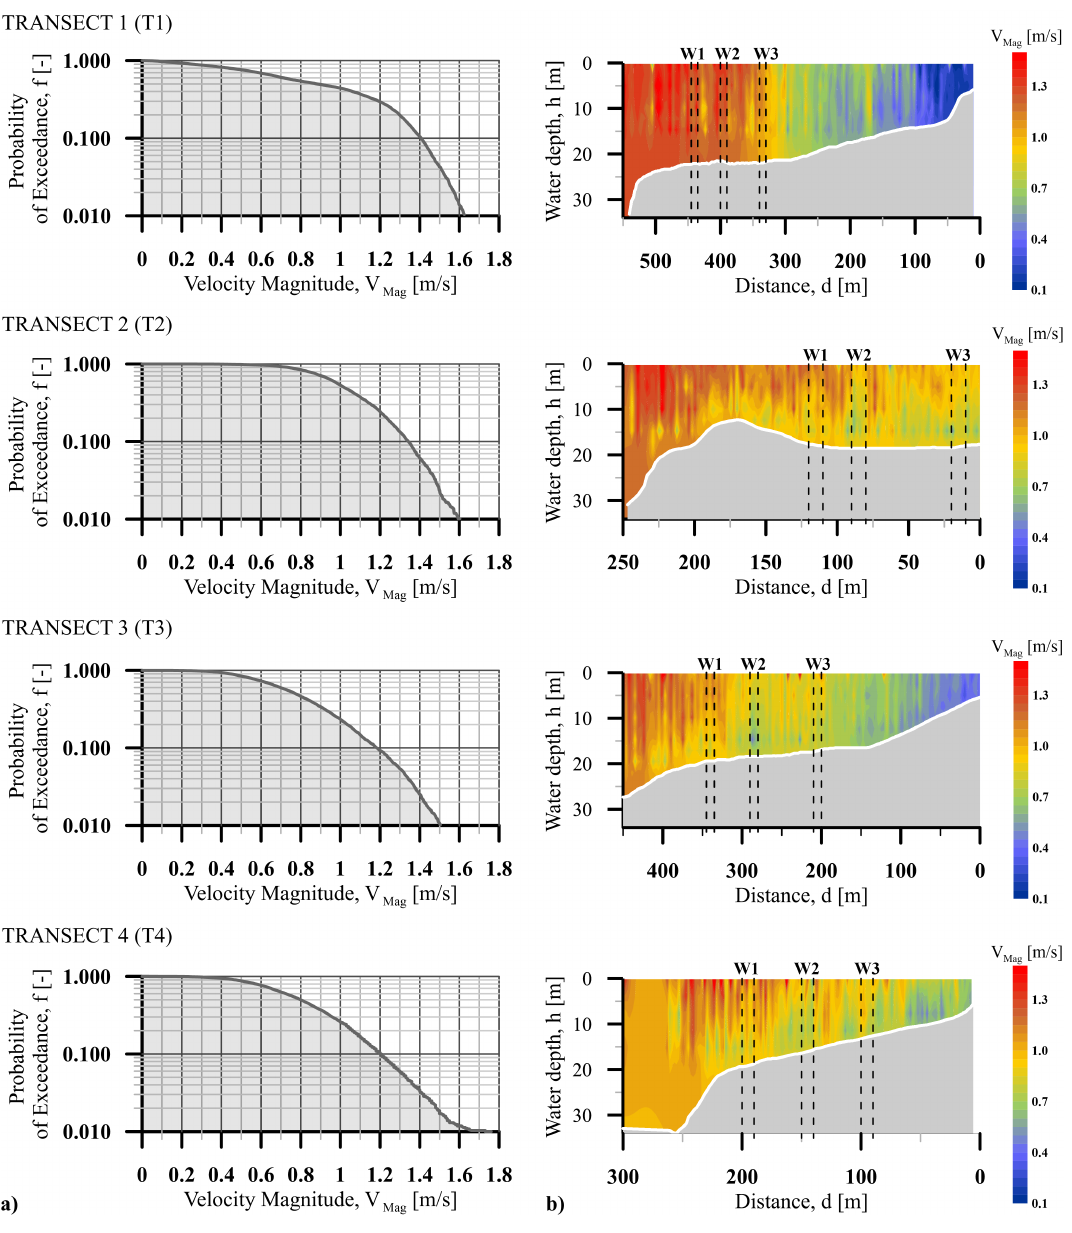
Figure 6. Transects T1–T4 in the north-west portion of Cozumel Island: ( a ) exceedance curves of marine current velocities; and ( b ) velocity profiles. Location of 10-m windows (W1–W3) at each transect for a practical estimate of the power